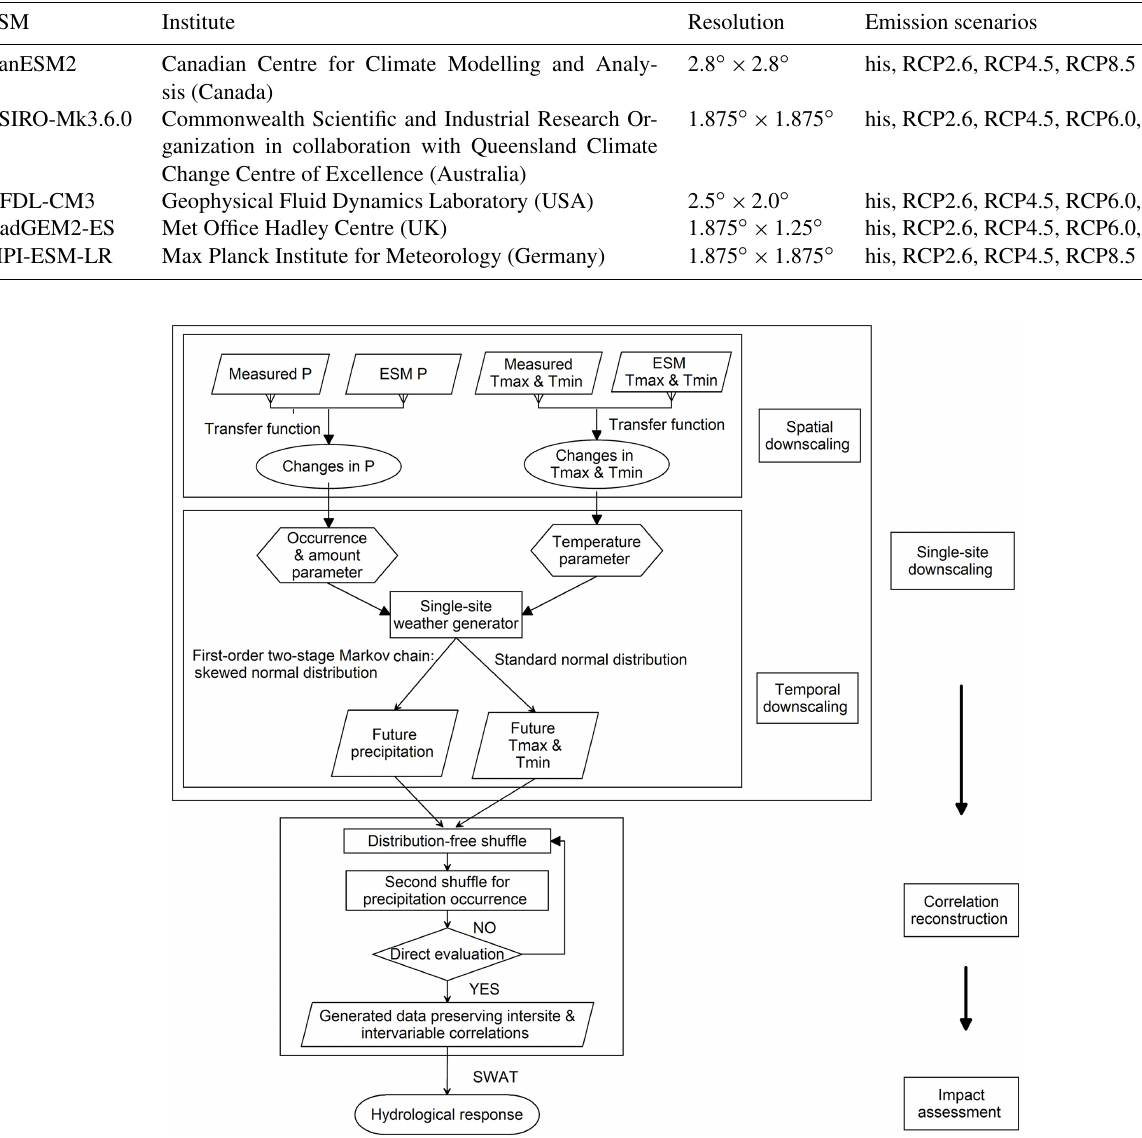
monthly observations and the ESM data for each